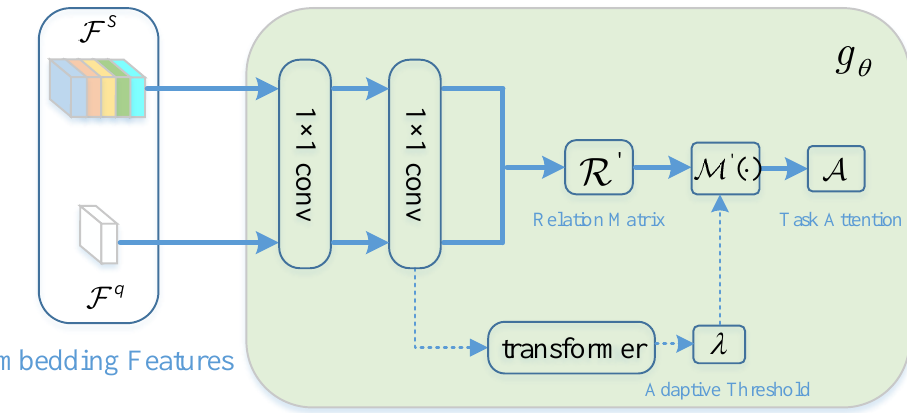
Figure 5. The schematic of task-adaptive attention